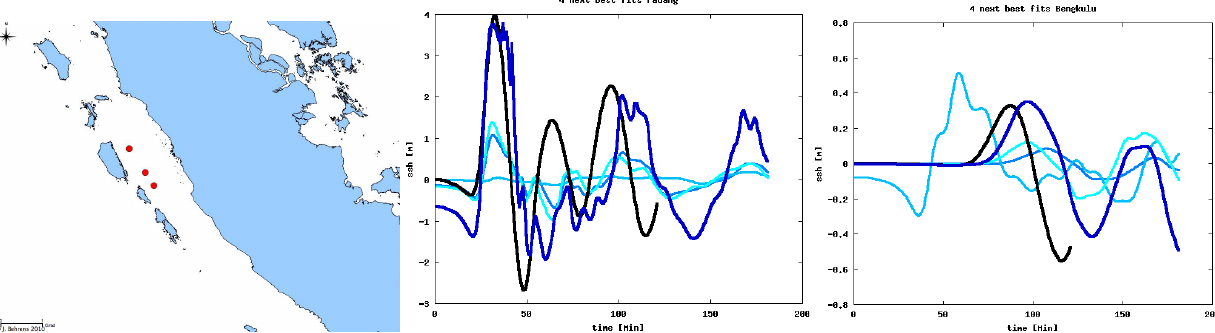
Fig. 11. Benchmark experiment with given seismic parameters, arrival times and wave height time series at buoy locations (see Fig. 9 for description of the three panels).